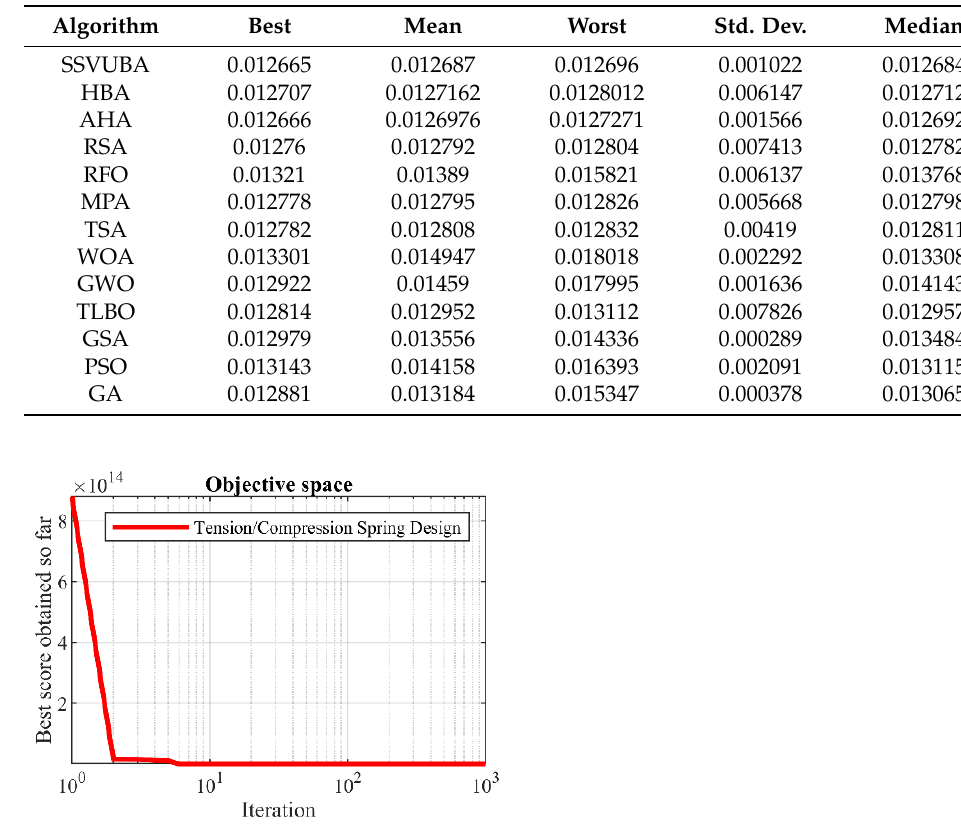
Table 17. Statistical results of optimization algorithms for the tension/compression spring design problem.